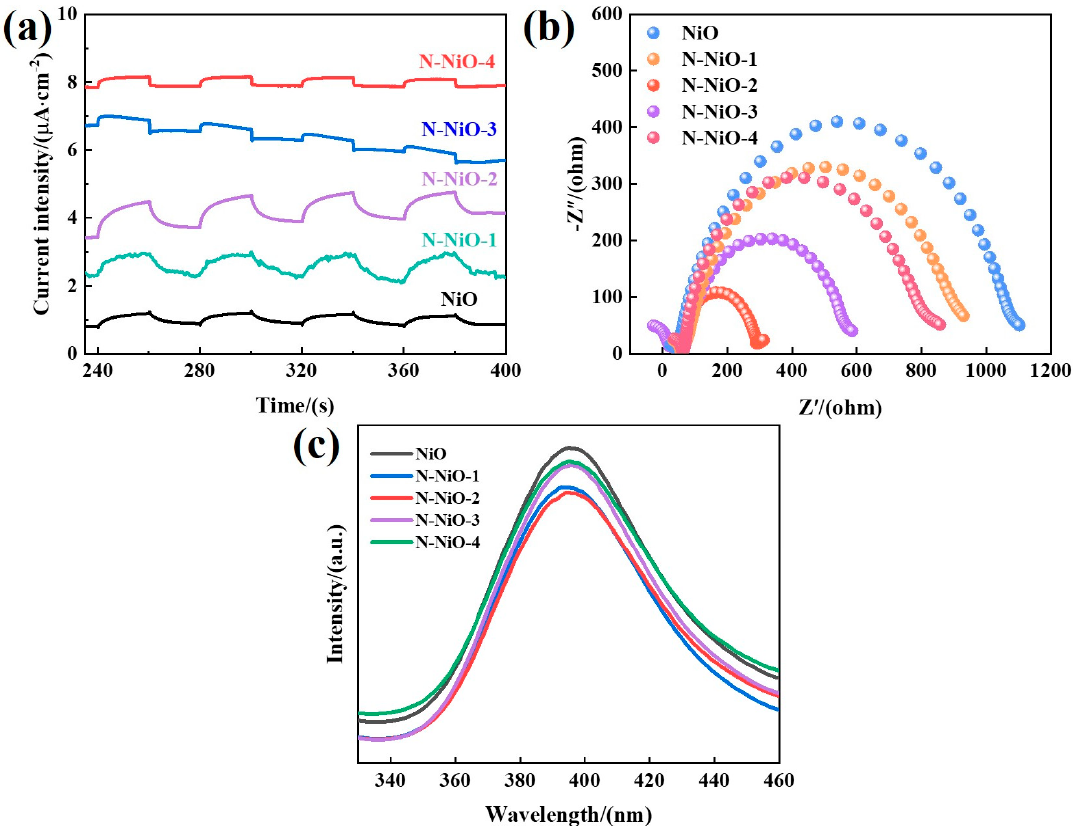
Figure 6. ( a ) Photocurrent-response curves; ( b ) electrochemical-impedance spectra; ( c ) steady-state PL spectra (excitation wavelength: 250 nm).